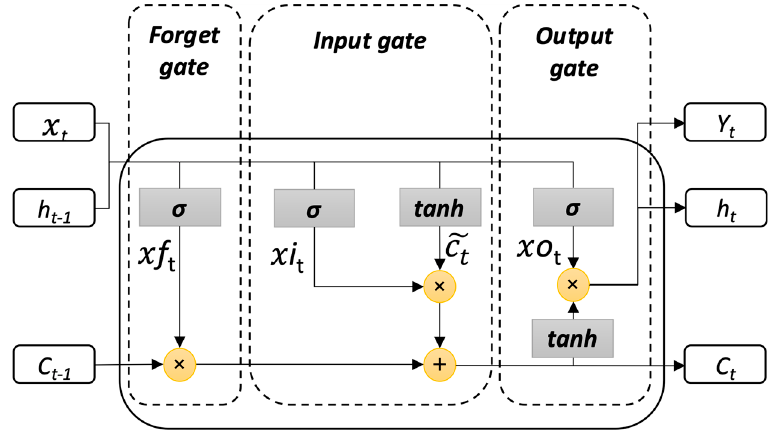
Figure 1. The architecture of a long short-term memory network.